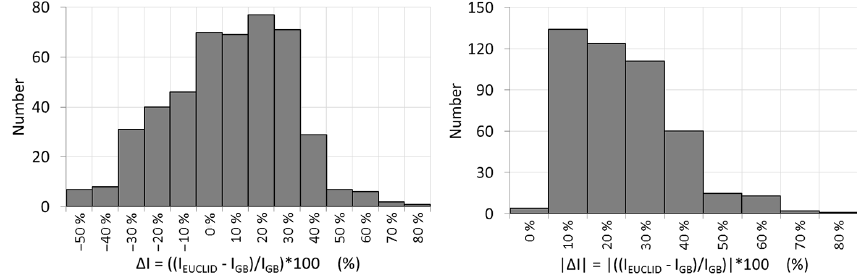
Figure 9. Histograms of (a) signed and (b) absolute EUCLID peak current estimation errors, given as a percentage of the directly measured GBT current ( (cid:49)I % = (( I EUCLID − I GB )/I GB ) × 100 for 464 return strokes in